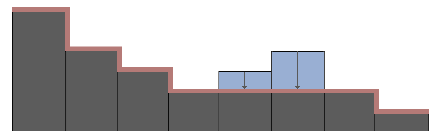
Figure 3. The pit removal by carving method (Bartak,